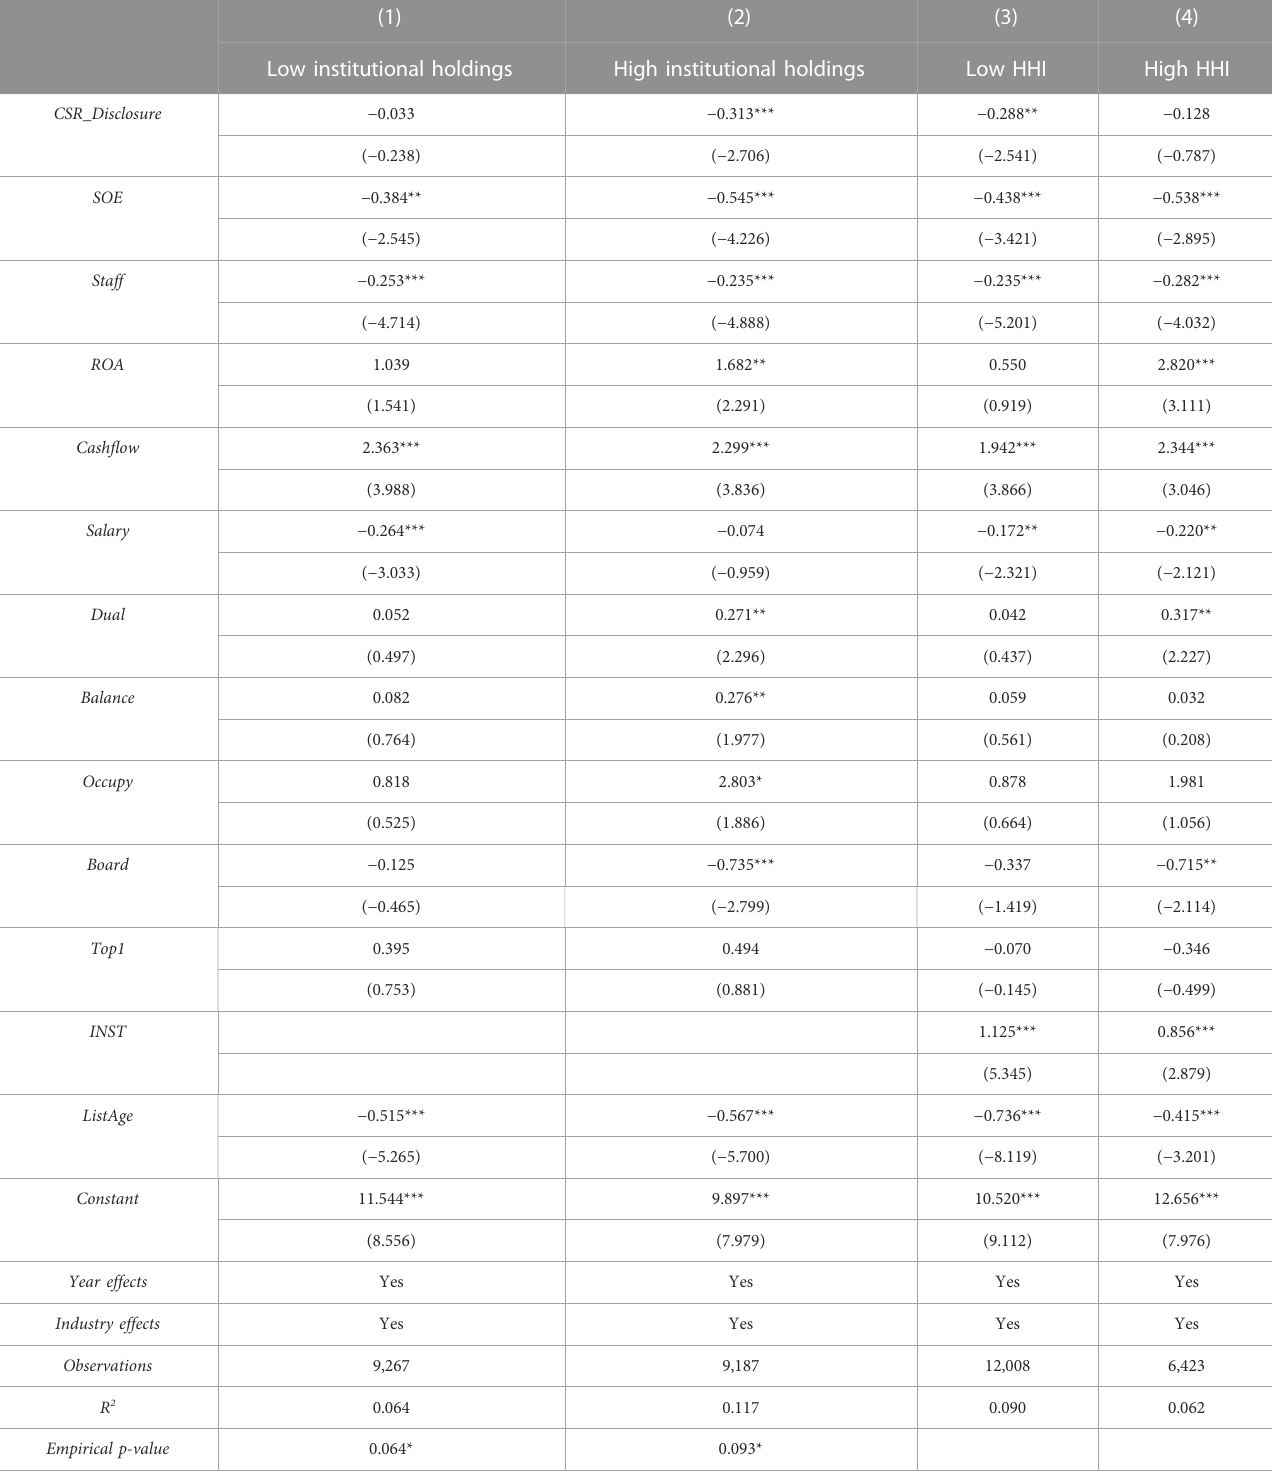
Note: This table reports regression results with low vs. high institutional shareholdings and low vs. high HHI., The research adjusts standard errors for heteroscedasticity. Numbers in parentheses represent t-values. ***, **, and * indicate signi fi cance at the 1%, 5%, and 10% levels respectively. The empirical p -value is used to test the signi fi cance of the coef fi cient ( CSR_Disclosure ) difference between groups, which is obtained through 1,000 times self-sampling